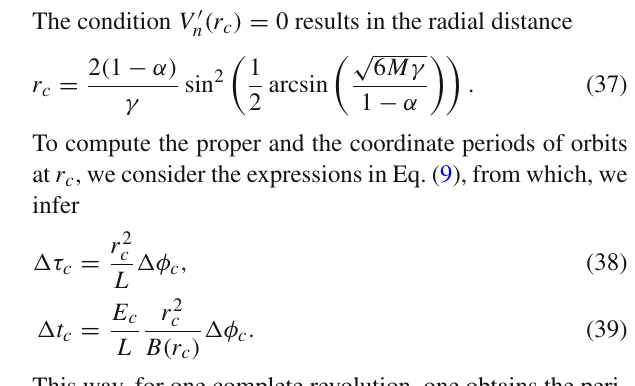
Fig. 6 The effective potential for angular null geodesics plotted for γ = 0 . 001 and L = 3. Altering the values of L only affects the scale of the potential and leaves its shape unchanged. For this particular poten- tial, the turning points are located at r d = 5 . 81 and r f = 2 . 93 corre- sponding to E 2 = 0 . 12, and r c = 3 . 76 corresponding to E 2 c = 0 .